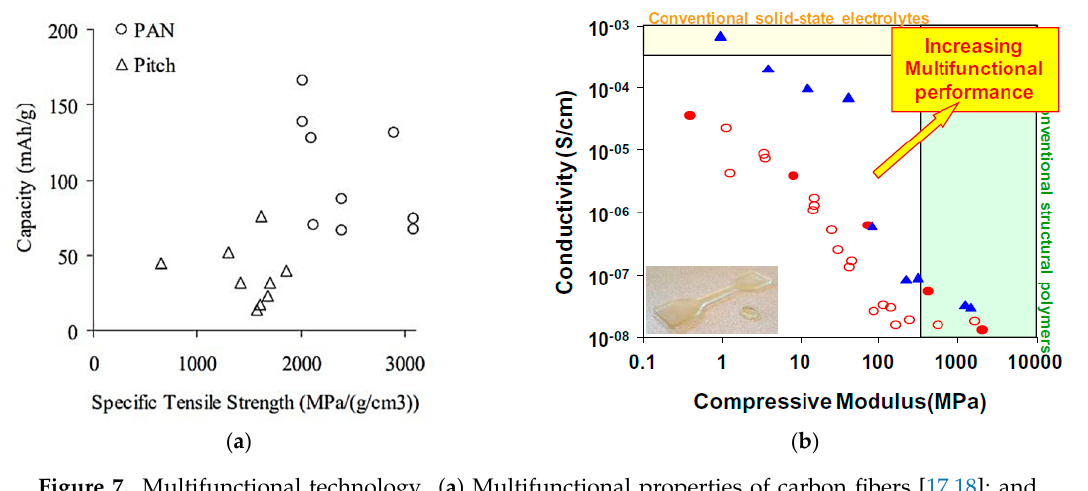
Figure 7. Multifunctional technology. ( a ) Multifunctional properties of carbon fibers [17,18]; and ( b ) multifunctional performance of polymer-based structural electrolytes [17]. In ( b ), open circles correspond to homopolymers electrolytes, filled circles are copolymers prepared from the two monomers whose homopolymers yielded the highest conductivity and rigidity, triangles correspond to “gels” comprising a structural polymer and liquid electrolyte in different volume ratios [17].